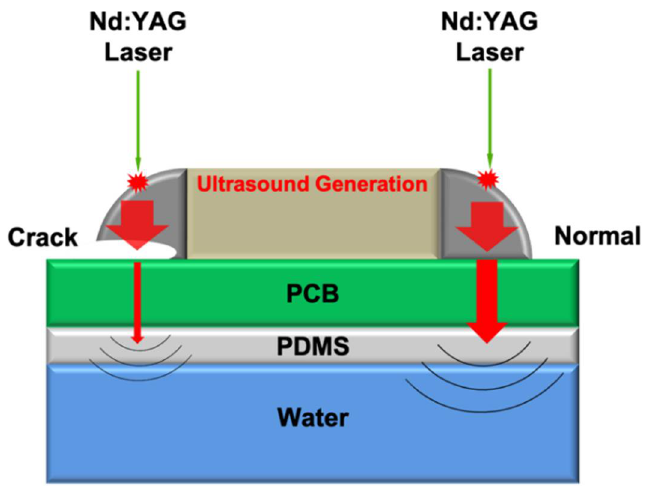
Figure 1. Principle of noncontact laser ultrasonic system.